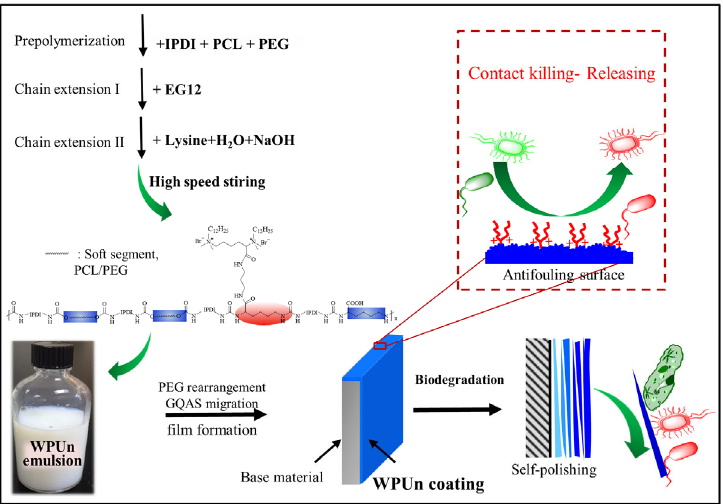
Figure 1. Schematic structure of WPUn coatings with anti ‐ fouling surface.